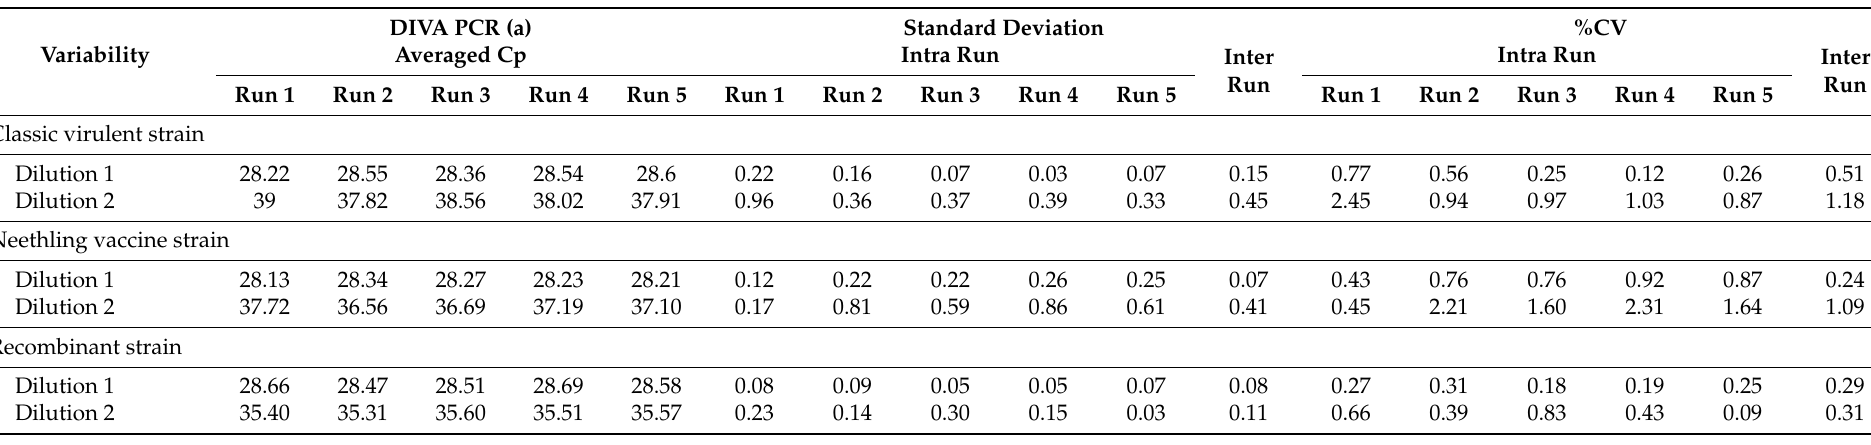
Table 4. The intra- and inter-run variability results of the DIVA real-time PCR. Ct values and %CV of five runs of four repeats of a low and high dilution of classical and recombinant wild-type strains (WTR) and vaccine strains